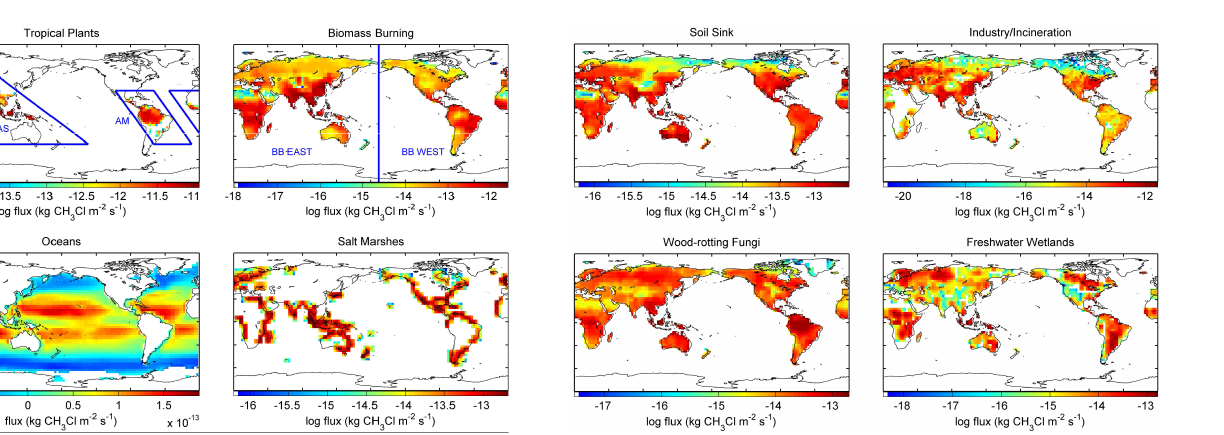
Fig. 3. Annual average distributions of reference CH 3 Cl emissions. Emission magnitudes and patterns vary by month. Tropical plants (America, Asia, and Africa) and biomass burning (East and West) have been further subdivided for the inversion. Note that the maps are on a log scale except for the oceans which have a linear scale.